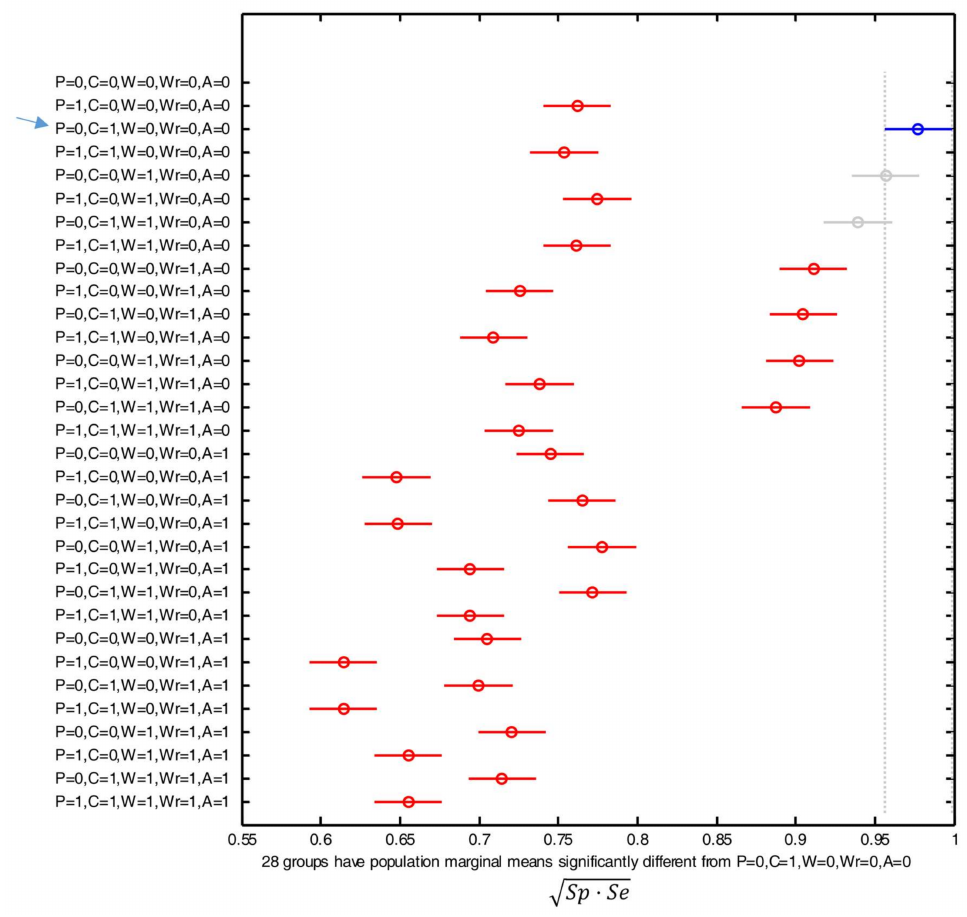
(cid:112) Sp · Se or geometric mean of the Figure 11. Comparison of the means of the performance metric ( sensitivity and the specificity) obtained with the SVM algorithm for all the possible combinations and positions of the sensors. The positions are indicated as: P (Pocket), C (Chest), W (Waist), Wr (Wrist) or A (Ankle). For each combination, the y-axis of the figure indicates with ‘1’ or ‘0’ whether the corresponding sensor is considered (‘1’) or not (‘0’) for the detection decision. The combination with the best results is indicated with a blue